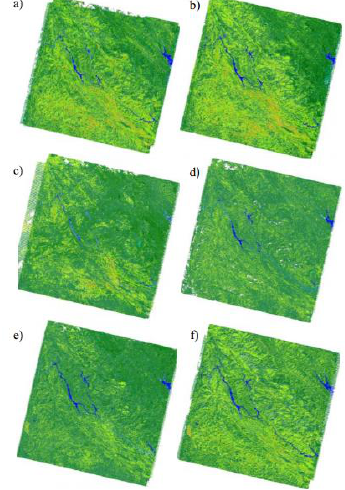
Figure 4. The six bimonthly cloud free land covers of year 2017 for periods: a) January-February, b) March-April, c) Yellow green: open forest; Blue: water; Orange: bare